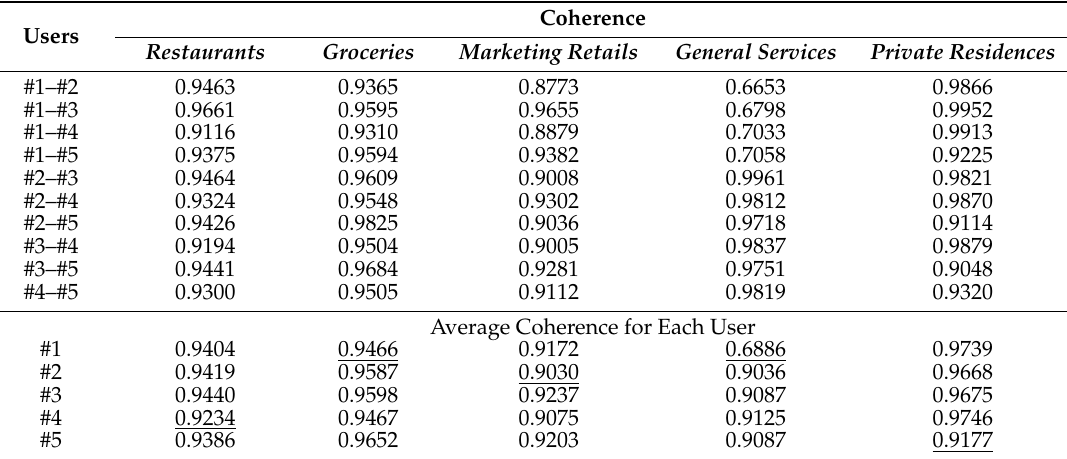
Table 1. Coherence Values between Active Power Signals.